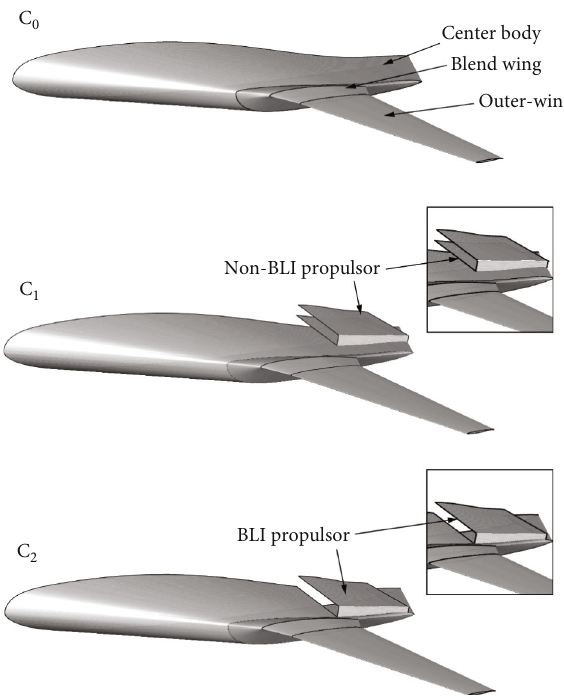
Figure 5: Con fi gurations used in the energy-based aerodynamic performance